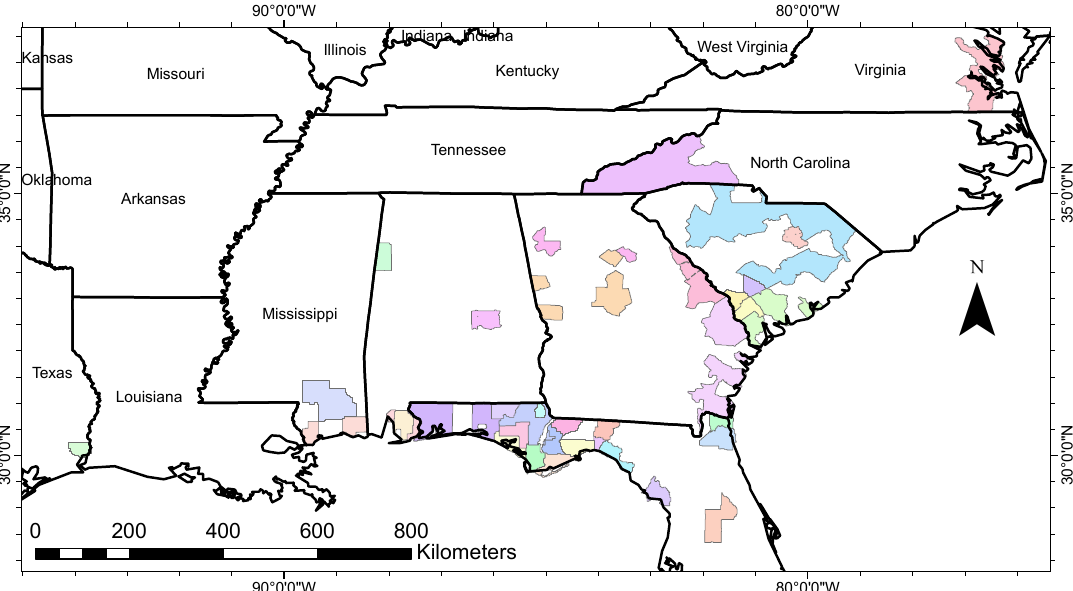
Figure 1. ALS data from 38 projects spread across eight states of USA were used in this study. Each project is shown in a different color. The total land area covered by these projects is approximately 208,000 sq. km. This region is dominated by loblolly pine, with some slash pine ( Pinus elliottii Engelm.) in the extreme